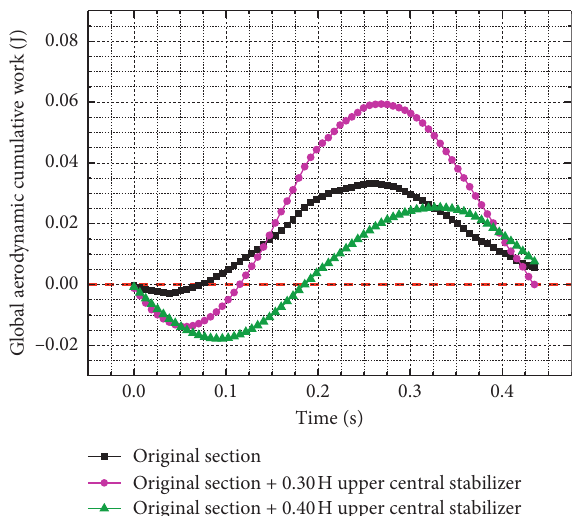
Figure 11: Global aerodynamic cumulative work for each time